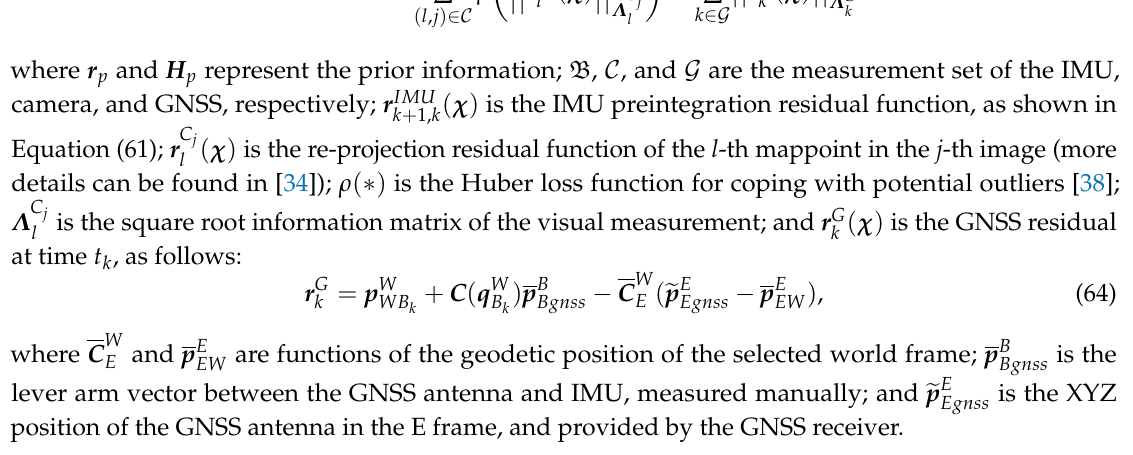
Table 1. The technical parameters of MTi-G-710 and POS620.